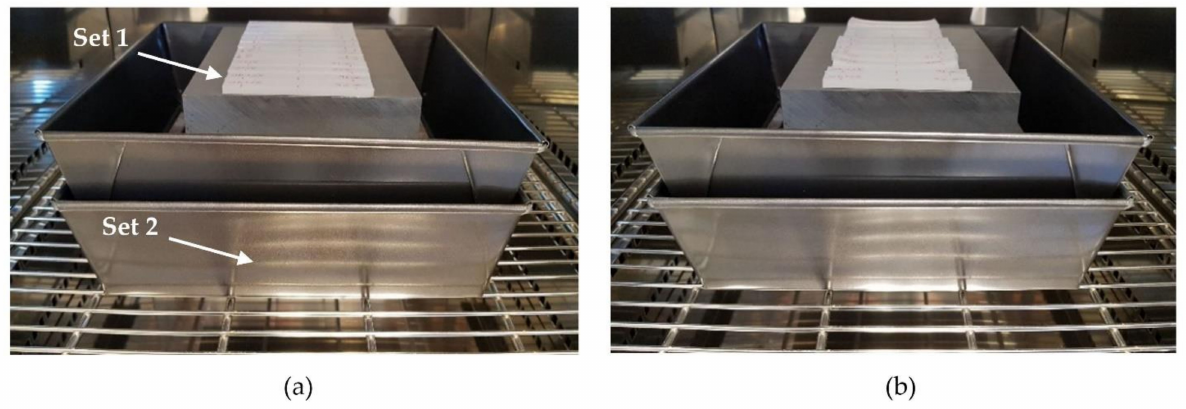
Figure 5. ( a ) Samples before thermal treatment in the furniture; ( b ) after thermal process, deformation is clearly visible in samples of Set